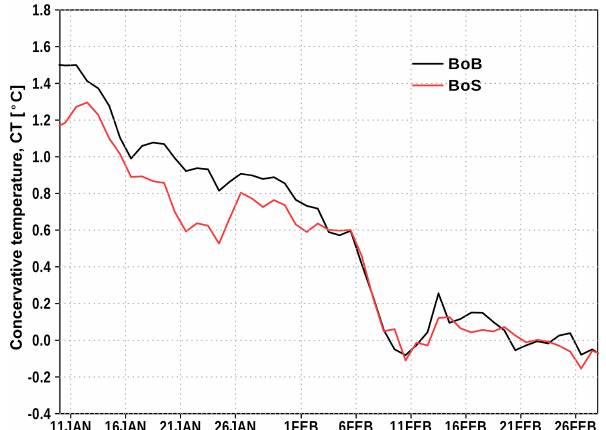
Figure 11. Time series of Bothnian Sea and Bay surface tracer at station 9 (Fig. 3). Panel (a) shows the vertical distribution of Both- nian Sea surface water; panel (b) shows the concentrations of Both- nian Sea (red) and Bothnian Bay (black) surface water, and the con- centration of brine (dashed, right y axis) in the bottom water at sta- tion 9; panel (c) shows the mean age of Bothnian Sea and Bothnian Bay surface water in the bottom water at station 9.